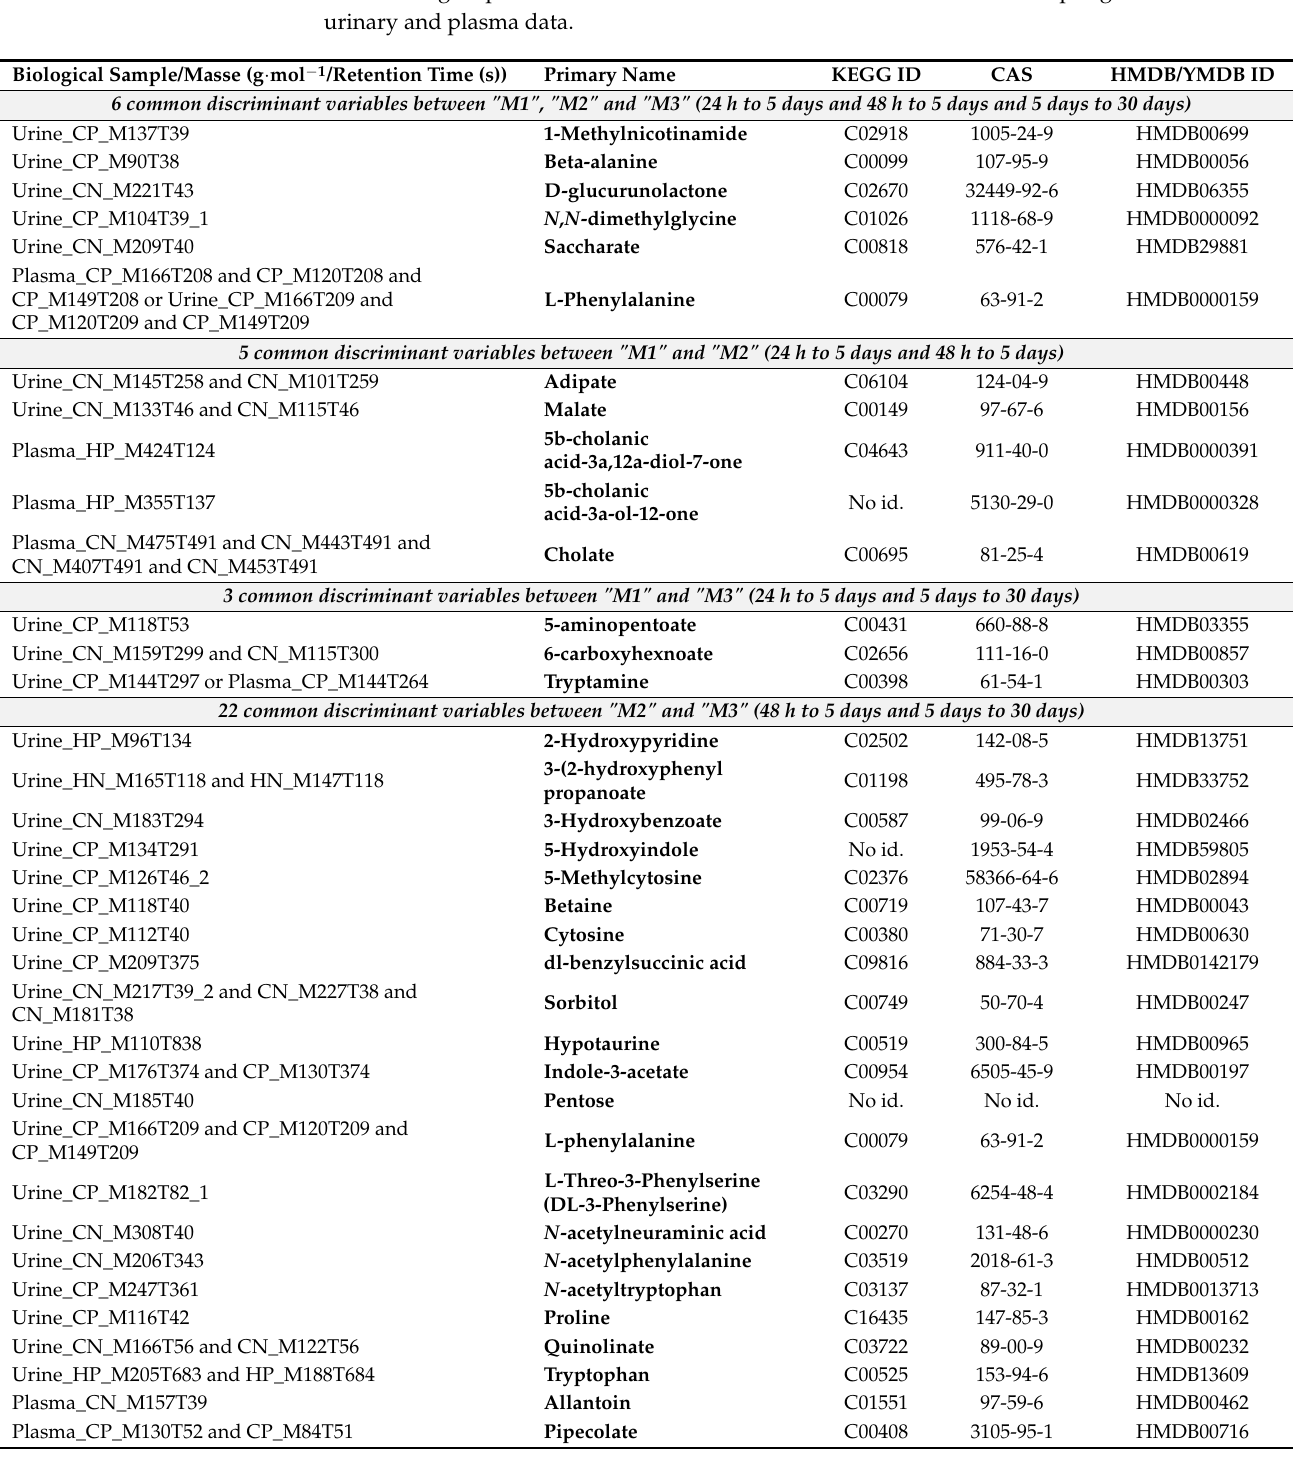
Table 3. The discriminant variables detected in common to at least two models calculated between the control group and the low doses of natural uranium for different sampling times in annotated urinary and plasma data.